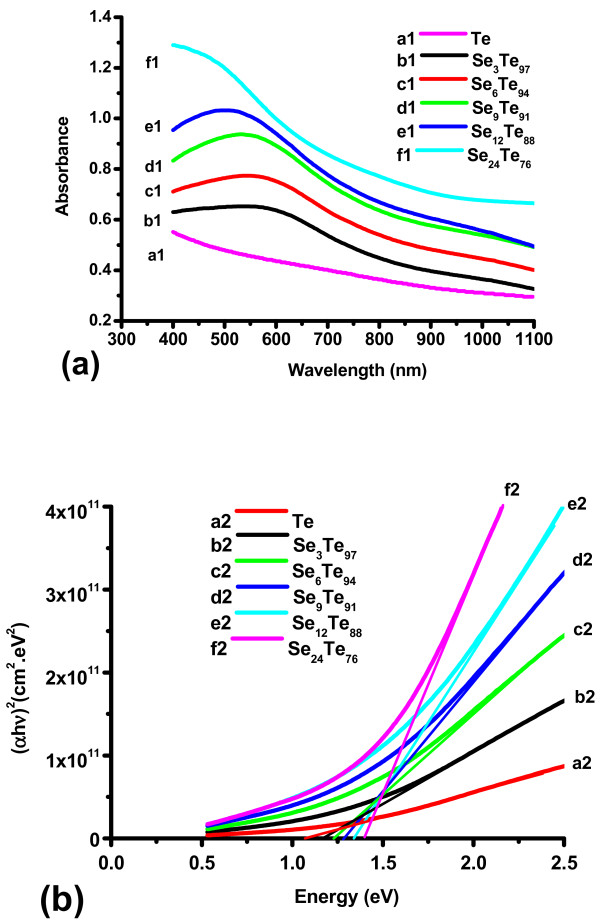
UV-visible absorption spectra (a) and (αhv)2against photon energy (hν)(b). For the thin films of SexTe100 − x nanoparticles.